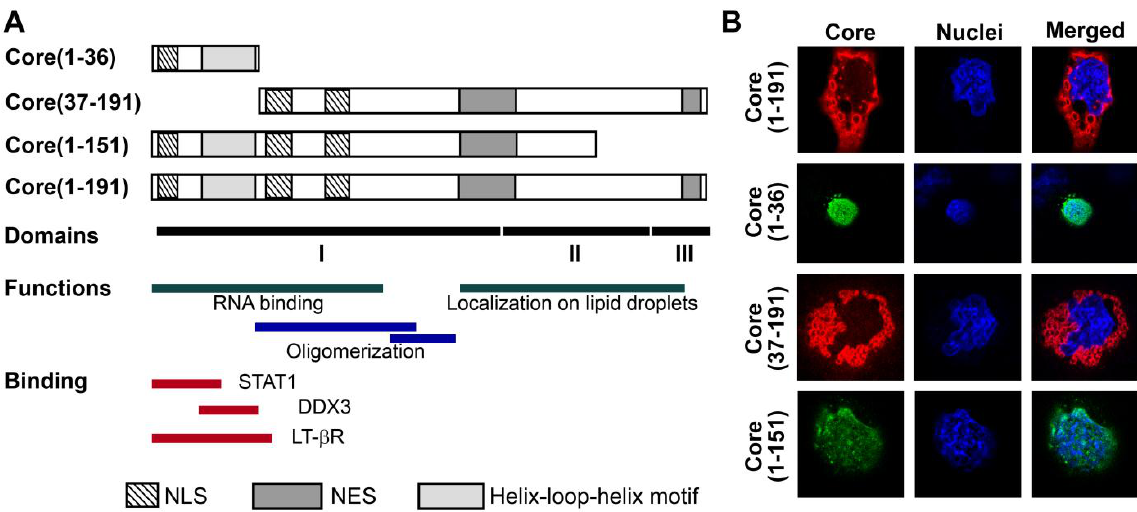
Figure 1. Structure and expression of HCV core variants used to induce oxidative stress and oxidative stress response. ( A ) Schematic representation of HCV core and its truncated forms: the N-terminal fragment aa 1-36, the N-terminally deleted fragment encompassing aa 37–191 and the C-terminally deleted variant encompassing core aa 1–151, dubbed core(1–191), core(1–36), core(37–191) and core(1–151), respectively. Charts below represent the known elements of core structure: structural domains [24], domains responsible for RNA-binding [24], oligomerization [24], localization to lipid droplets [25]; and binding to host proteins STAT1 [36], DDX3 [37], LT-betaR [35]; as well as the position of the helix-loop-helix motif, nuclear localization (NLS) and nuclear export signals (NES) [34]; ( B ) Intracellular localization in Huh7 cells of the full-length and truncated HCV core variants (depicted on the left): staining with primary rabbit anti-core and secondary anti-rabbit antibodies conjugated to FITC or TRITC (panel I), nuclear staining with Hoechst 33258 (panel II), overlay of panels I and II (panel III) (see Materials and Methods Section for details).